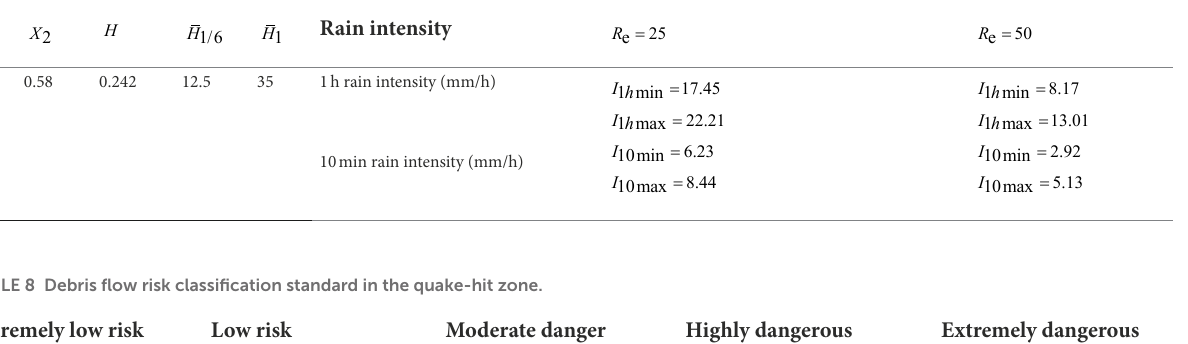
TABLE 7 Critical rainfall range (frequency method).